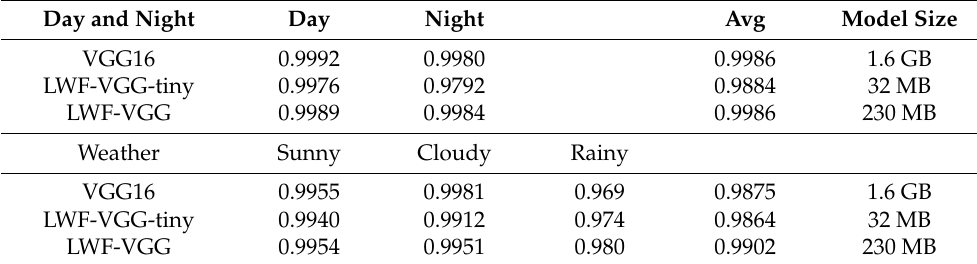
Table 4. Accuracy of VGG16, LWF-VGG, and LWF-VGG tiny as classifiers. Avg: average.